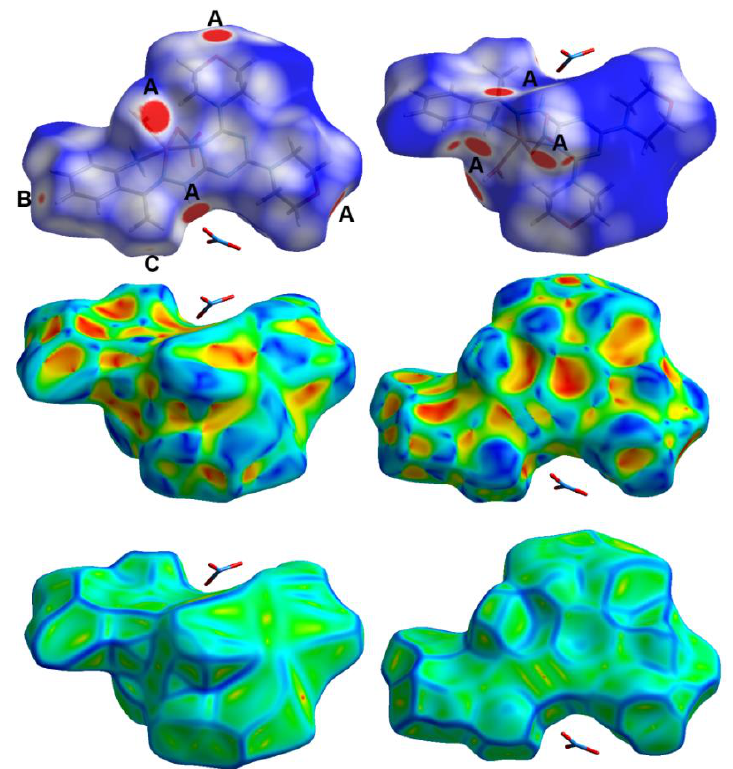
Figure 10. Hirshfeld maps of complex 1 . The most important interactions are ( A ) O…H, ( B ) H…H and ( C ) C…C.